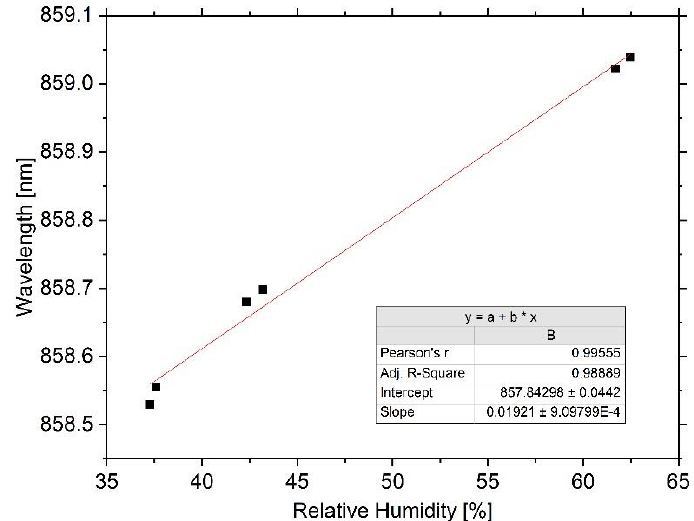
Figure 8. Results of the humidity sensitivity experiment. A linear redshift can be approximated over the investigated range from 37.0% to 62.0%. The sensitivity due to moist air is 19.2 pm/%. For the investigated humidity range from 37.0% to 62.0%, a sensitivity of 19.2 pm/% is determined. Under the prerequisite of ensuring sufficient time constants, a linear sensor behavior